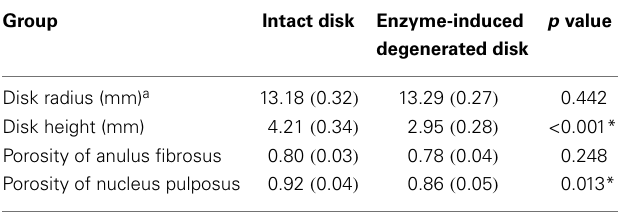
Table 1 |Average disk radius, height, and porosity of intact and enzyme-induced degenerative porcine intervertebral disks ( N = 18)